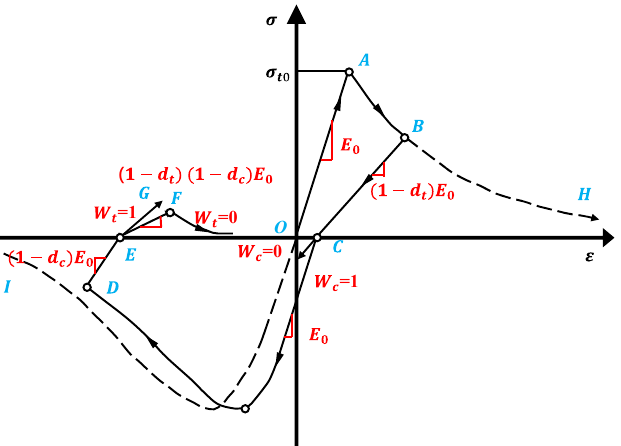
Figure 6. The concrete damaged plasticity model for the reinforced concrete pile.